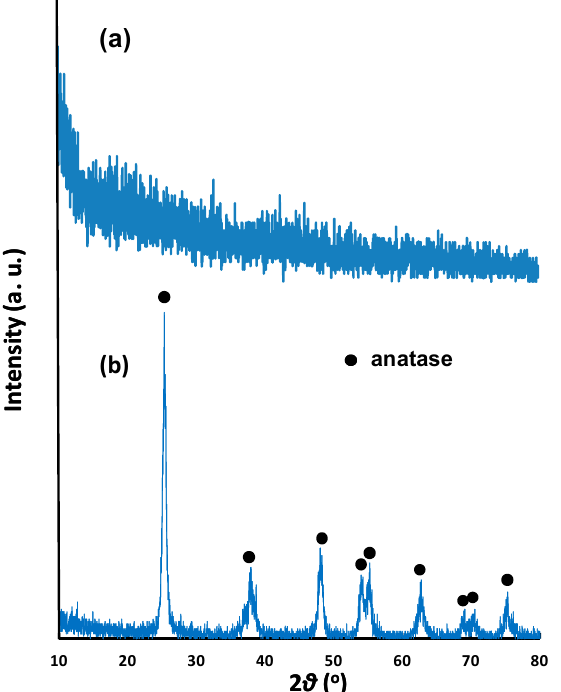
Figure 1. XRD patterns of ( a ) N- and Ni-coated TiO 2 thin film (NNT-F) and ( b ) N- and Ni-coated TiO 2 powder (NNT-P).